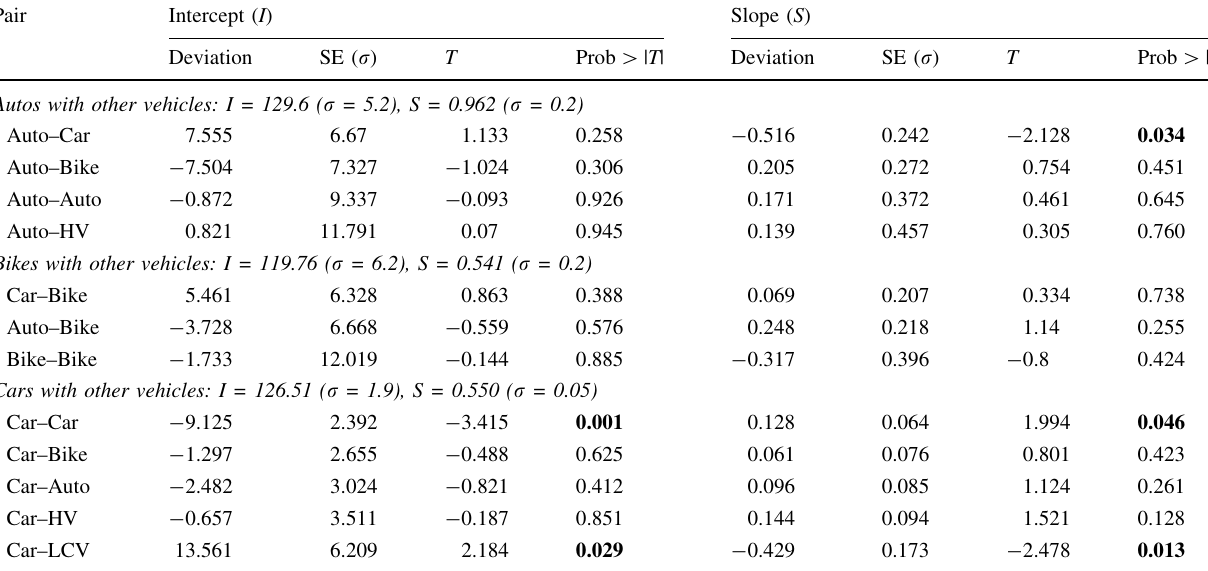
Table 3 Comparison of C and v for different vehicle pairs with their overall behavior Pair Intercept ( I ) Slope ( S ) Deviation SE ( r ) T Prob [ | T |